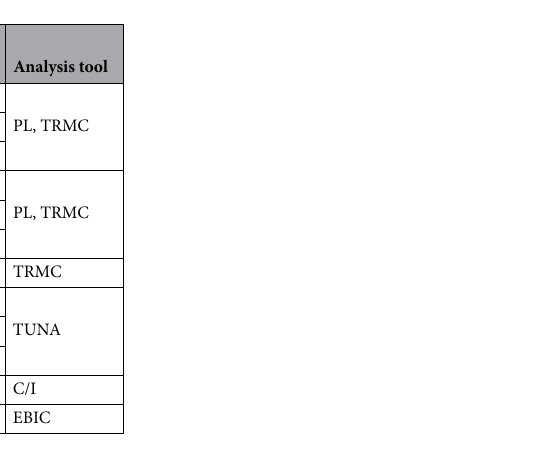
Table 1. CISe film